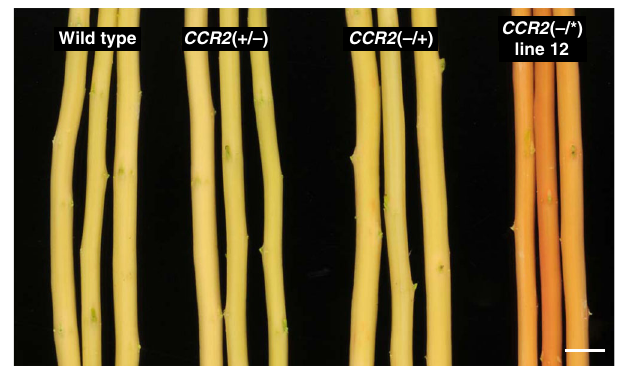
Fig. 6 Phenotype of debarked stems of CCR2 ( + / − ), CCR2 ( − / + ), and CCR2 ( − /*) line 12 poplars. Plants were grown for 11 weeks in the greenhouse. The red xylem phenotype was only present in CCR2 ( − /*) line 12. The status of the CCR2 alleles present in P. tremula × P. alba is denoted between the parentheses; the fi rst one represents that of the P. tremula allele, the second one that of the P. alba allele; + , wild type; − , knockout; *, protein-modi fi ed. The stems shown are representative of seven biologically independent samples per line. Scale bar = 1